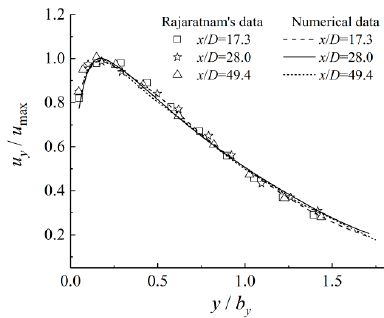
Figure 5. Nondimensional velocity profiles in the plane of symmetry of the wall jet.